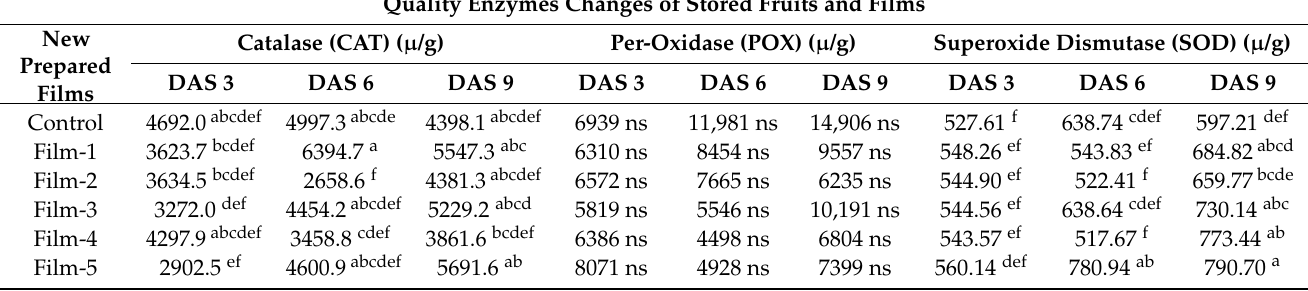
Table 5. Effects of new films on quality enzymes of catalase (CAT) ( µ /g) Peroxidase (POX) ( µ /g) superoxide dismutase (SOD) ( µ /g) (Golden Delicious).